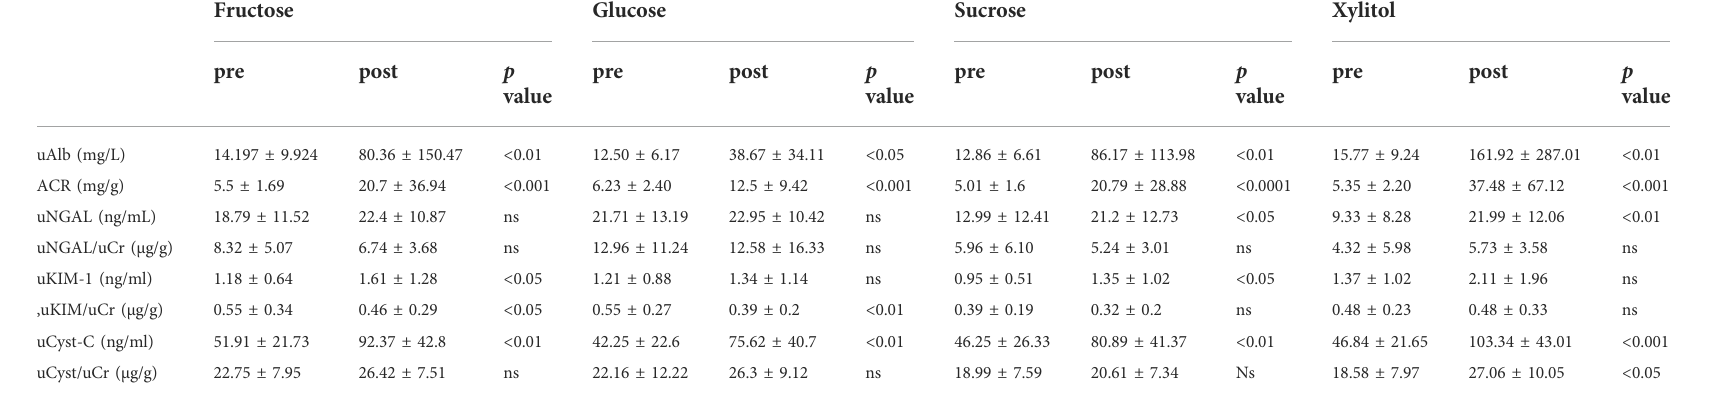
TABLE 8 Changes in urinary acute kidney injury